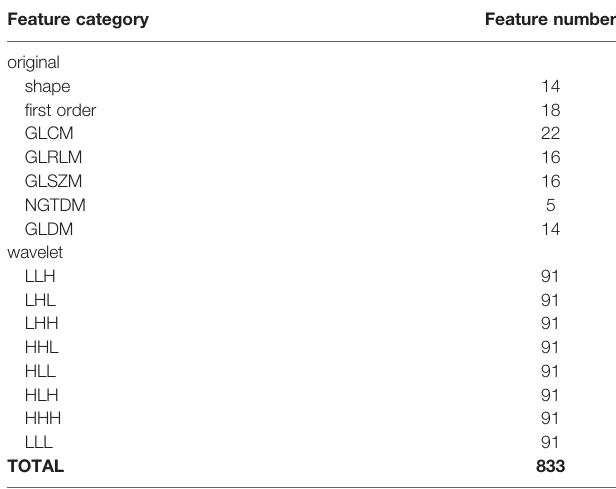
TABLE 1 | The list of the radiomics features. Feature category